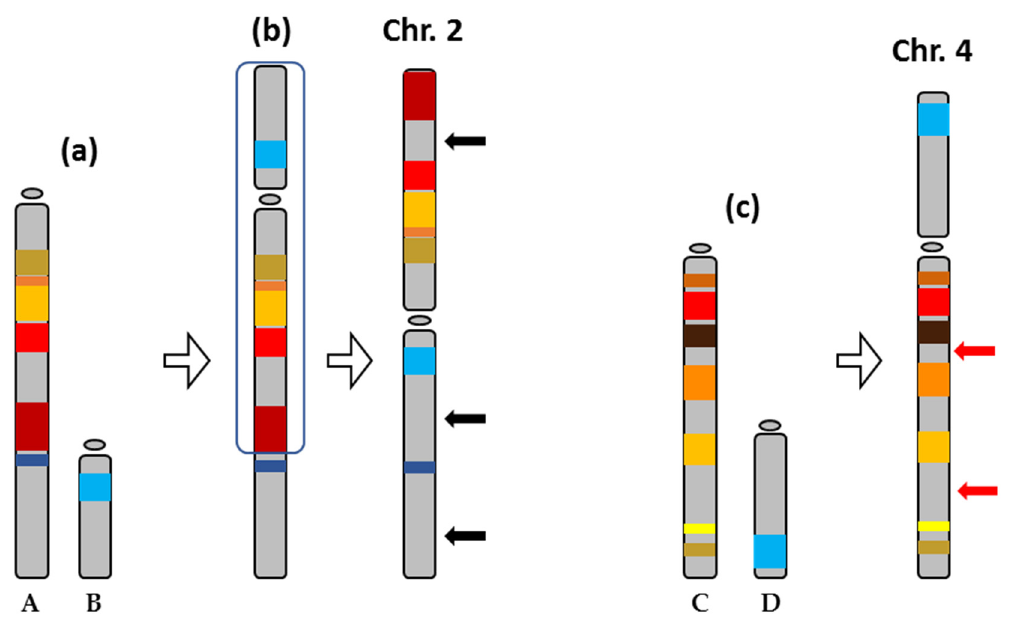
Figure 8. Evolution of the chromosomes 2 and 4 of Solea senegalensis from ancestral acrocentric chromosomes, represented as A, B, C, and D. ( a ) A Robertsonian translocation between A and B to originate a new submetacentric chromosome ( b ), which, after pericentric inversion (region inside the outline), formed the metacentric chromosome 2 of S. senegalensis . The black arrows indicate probable translocation events that gave rise to the present chromosome 2. ( c ) A Robertsonian translocation between other acrocentric chromosomes, C and D, gave rise to the submetacentric chromosome 4 of S. senegalensis . The red arrows indicate possible translocation events that resulted in the present chromosome 4.